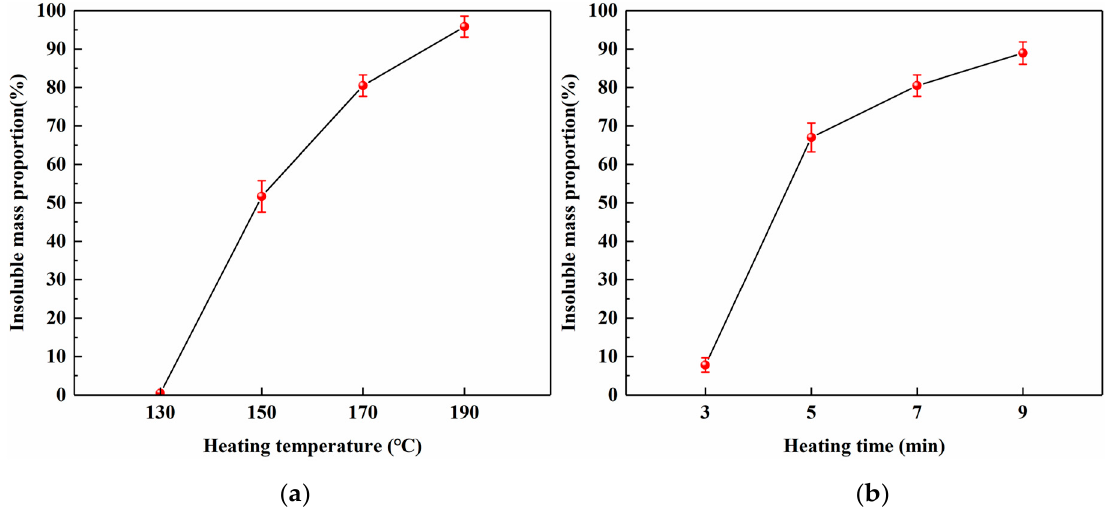
Figure 7. Effects of ( a ) heating temperature and ( b ) heating time on the insoluble mass proportion. Figure 7. E ff ects of ( a ) heating temperature and ( b ) heating time on the insoluble mass